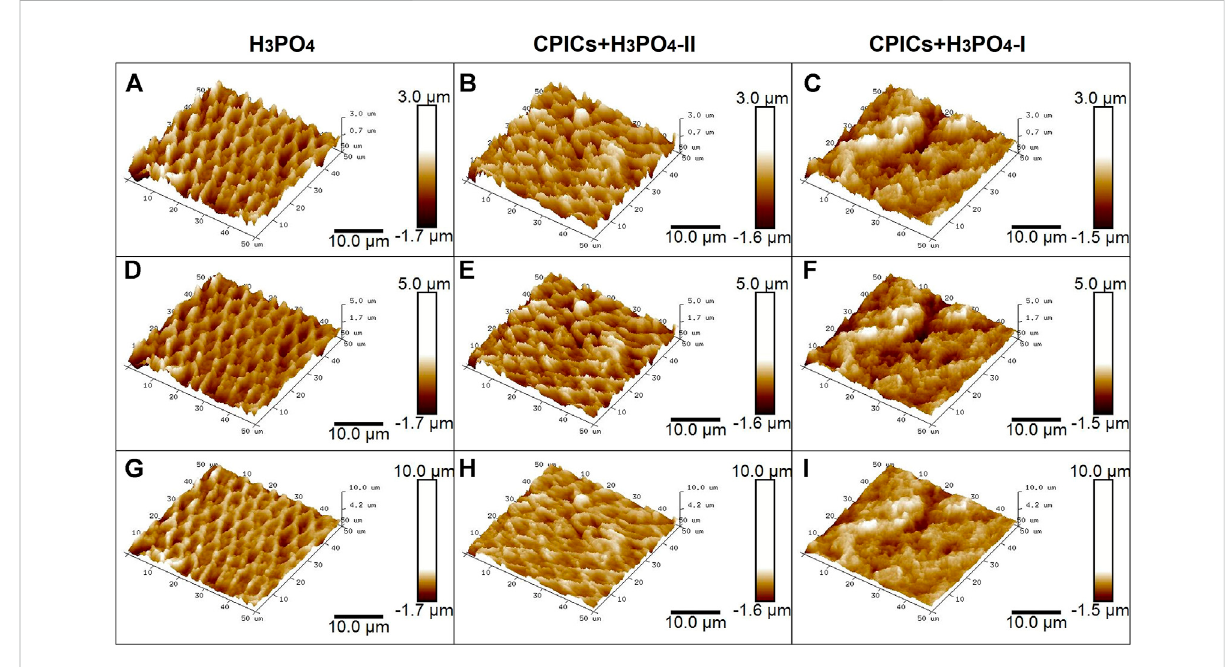
FIGURE 11 Atomic force microscopy images showing the acid-etched enamel. Each row represents a different range of measurement. The same results wereobtainedfordifferentmeasurementranges(seeeachcolumn). (A,D,G)